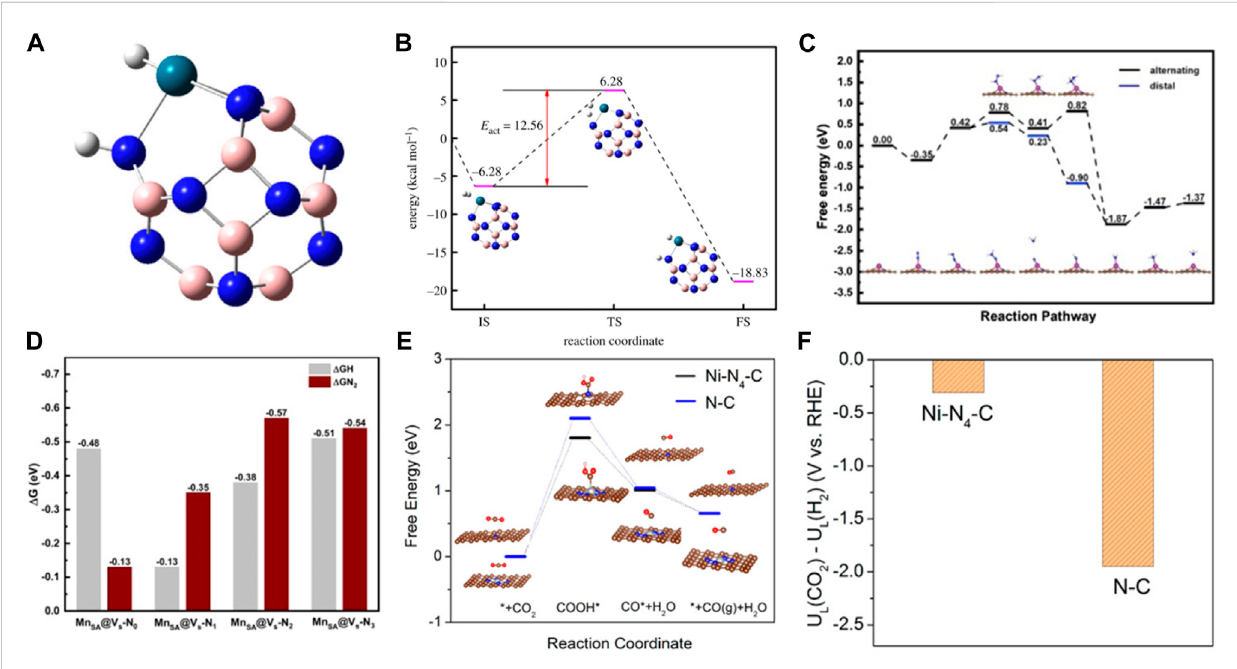
FIGURE 3 (A) The stable structures of H 2 absorbed on B 11 N 12 Pd SAC. (B) Energy barrier diagram of the B 11 N 12 Pd SAC for hydrogenation reaction and the schematic diagrams of initial (IS), transition (TS) and fi nal (FS) states. White spheres: H atoms, pink spheres: B atoms, blue spheres: N atoms, blue-green spheres: Pd. (Figure used with permission from Kang et al., 2017) (C) Free-energy diagrams for the NRR on Fe-N/C. (D) The difference between the free energy of H and N 2 atom ( fi gure used with permission from Zhao et al., 2020) (E) (a) The free energy diagram for CO 2 RR. (F) Limiting potential difference for CO 2 RR and HER on Ni-N 4 catalyst ( fi gure used with permission from Xie et al.,